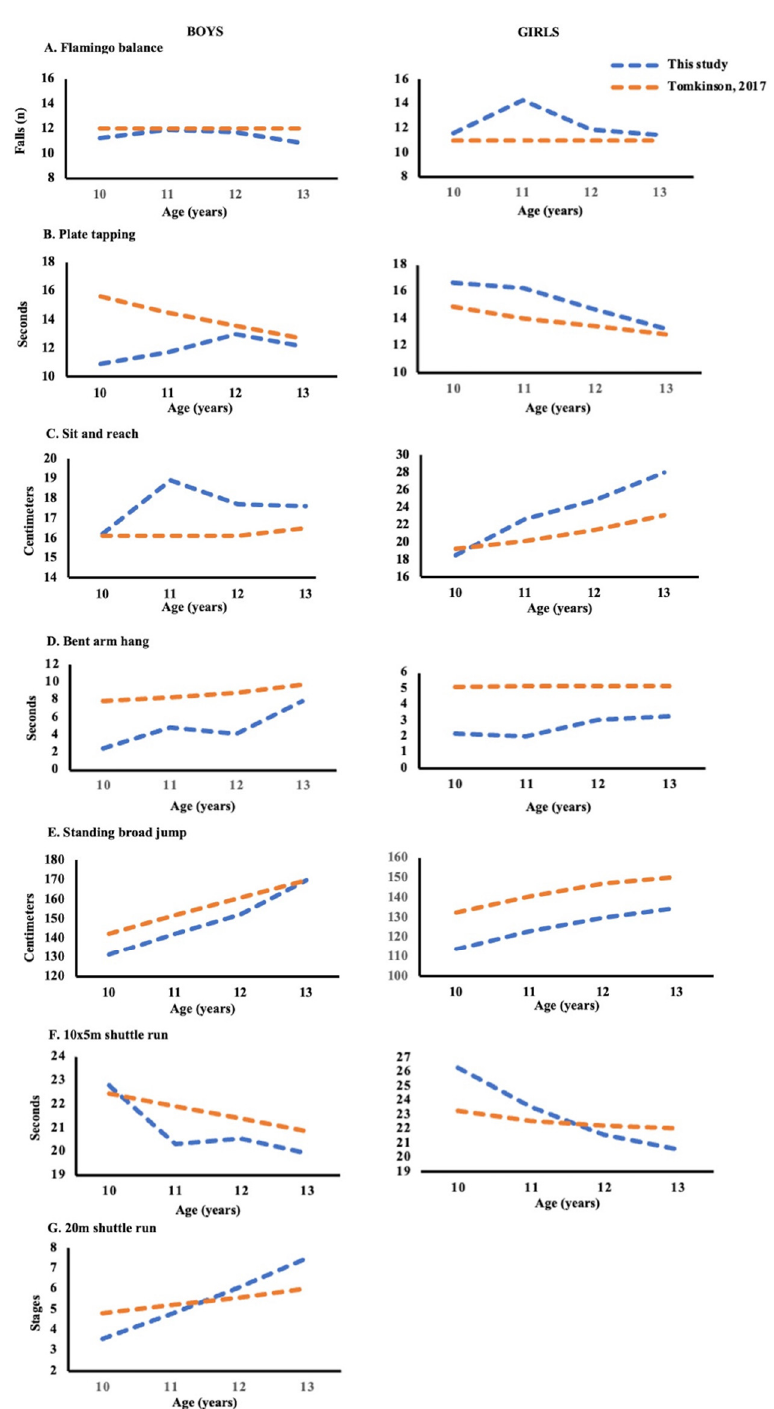
Figure 1. Comparison of 50th-percentile values of HRPF components evaluated in this study with the average score by gender and age obtained from more than 90 European studies [34].